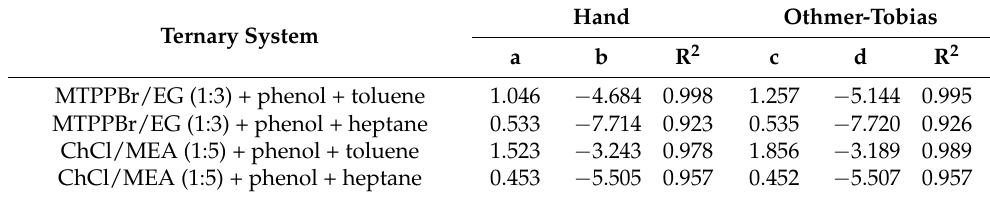
Table 5. Linear regression data and fitting parameters of Hand and Othmer–Tobias correlation for the ternary LLE